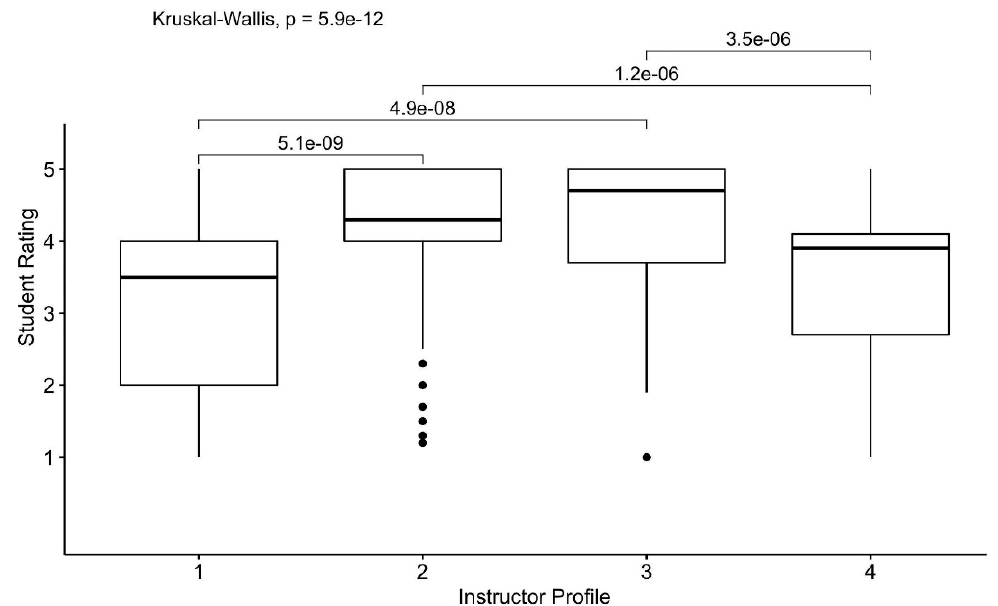
Figure 4. Shared Cultural Knowledge ratings according to instructor profile. Instructor 1 is a native speaker from Spain, Instructor 2 is a native speaker from Latin America, Instructor 3 is a Heritage Speaker of Spanish, and Instructor 4 is an L2 Spanish speaker.